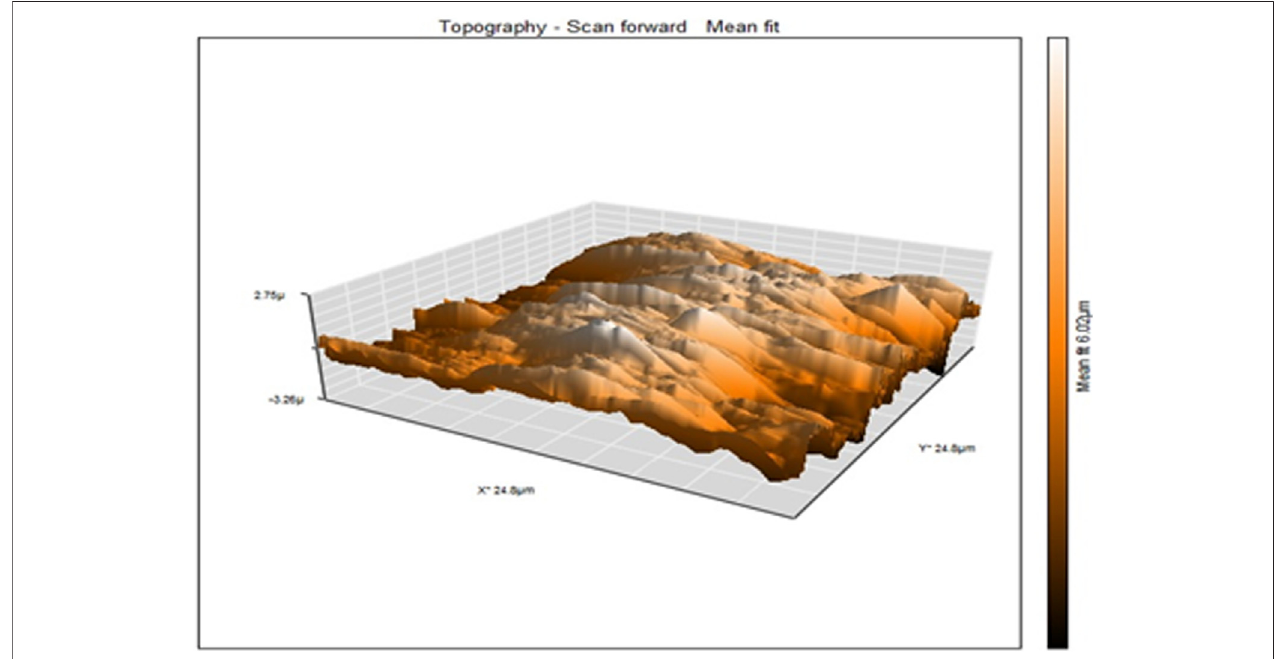
FIGURE 4 | AFM topographical images of electrospun PAA nano fi